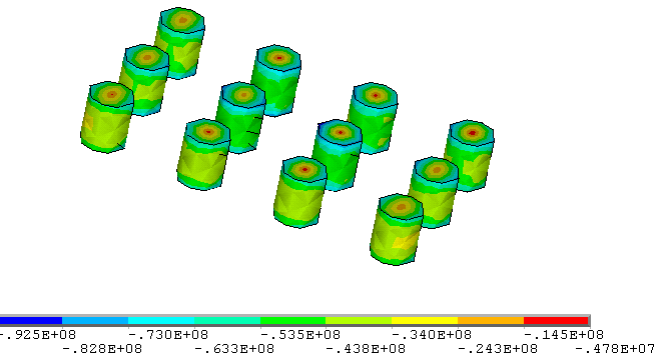
Figure 37. Minimum principal stress distribution of scheme 9 pillars at 1480 mL (parameters of